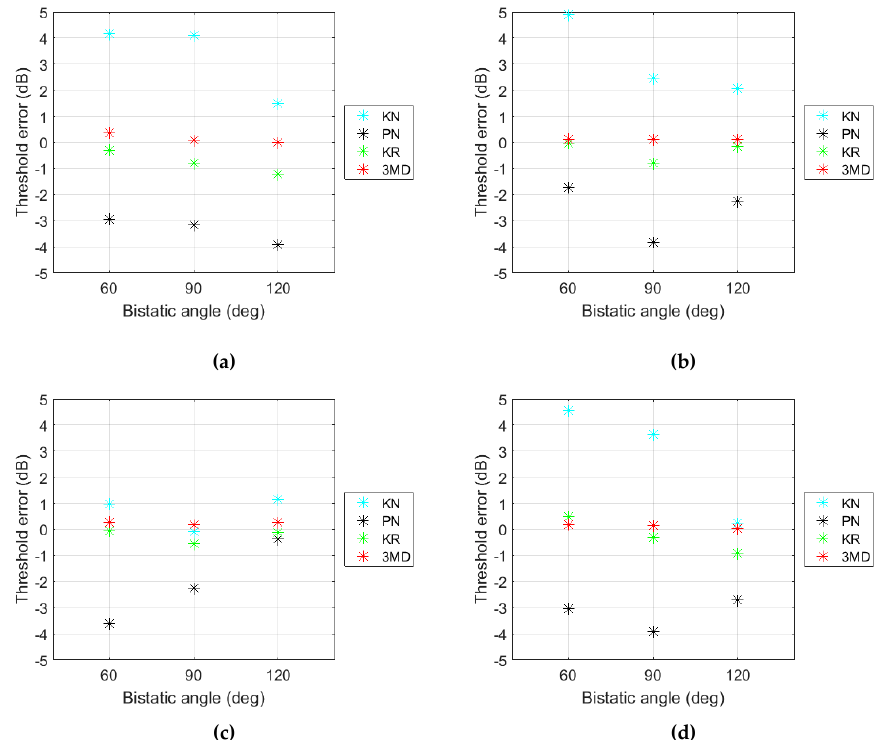
Figure 11. NetRAD S-band: Threshold error for a CCDF of 10 − 4 . ( a ) HH polarization, monostatic, ( b ) HH polarization, bistatic, ( c ) VV polarization, monostatic, ( d ) VV polarization, bistatic.